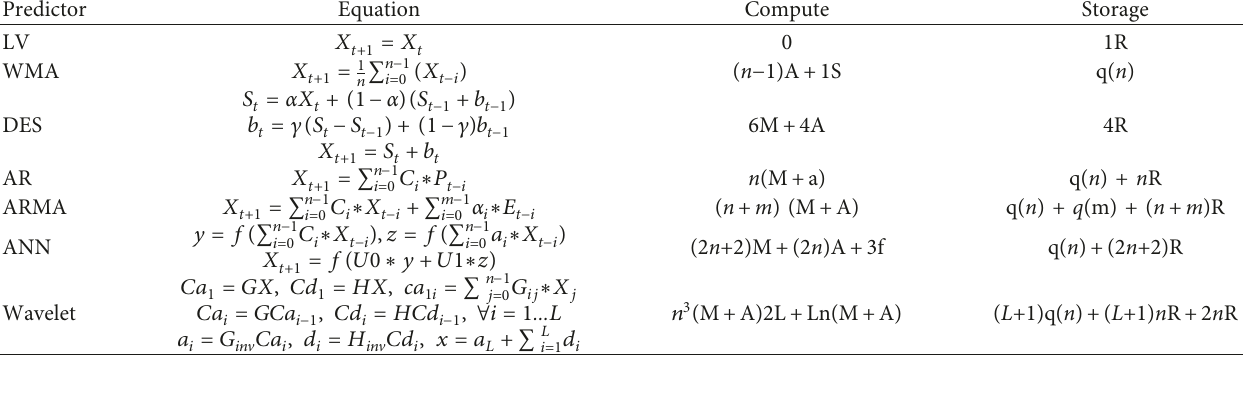
Table 1: A comparison of compute and storage requirements of traffic predictors where R � register, q( n ) � queue of size n , A � addition, S � shift, M � multiply, L � levels, and f � activation function.